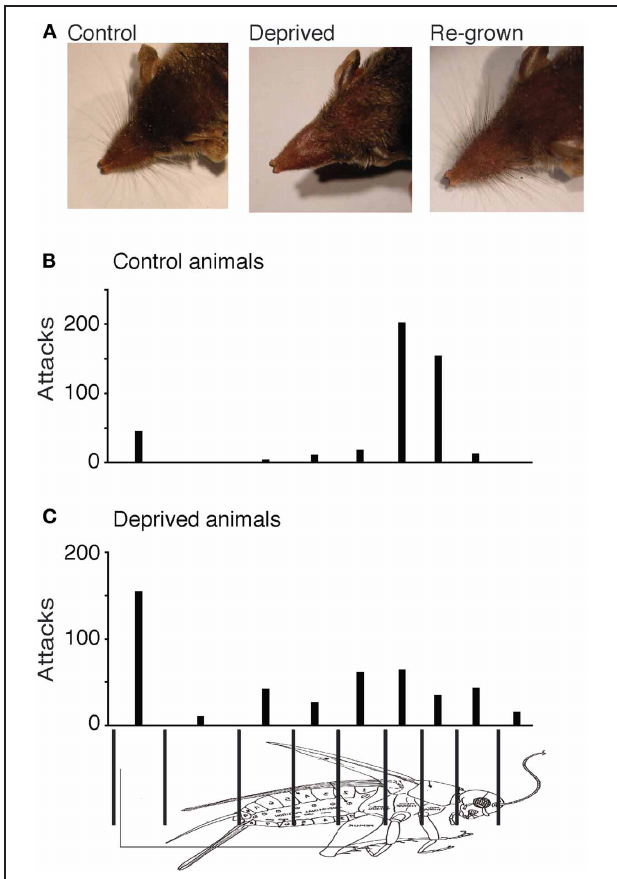
FIGURE 3 | Whisker deprivation. (A) Comparison between the whiskers of an untrimmed control animal (left), a whisker-trimmed animal at the end of the deprivation (middle) and the same animal after whisker-regrowth (right). (B) Attack histogram of control animals. (C) Attack histogram of deprived animals (after whisker regrowth). The fraction of attacks placed on the thorax (79% of 456 attacks) in control adults was significantly different from the fraction of thorax attacks (22% of 459 attacks) observed in deprived animals (Fisher’s exact test, two-tailed, p < 0 .